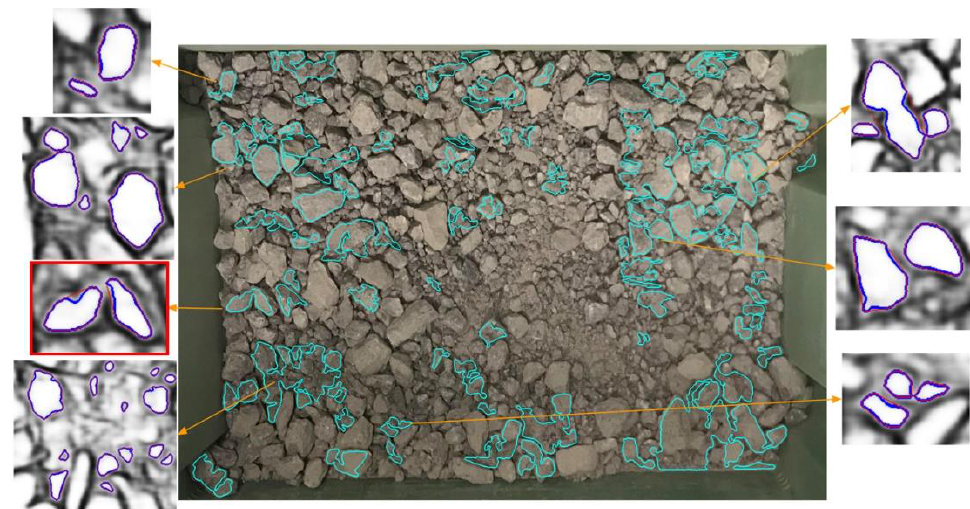
Figure 5. An example of raw image and processed results: ( a ) the raw image; ( b ) the binary image of detected edge; ( c ) all contours found; ( d ) fine region; ( e ) connected rock region; ( f ) single rock region.